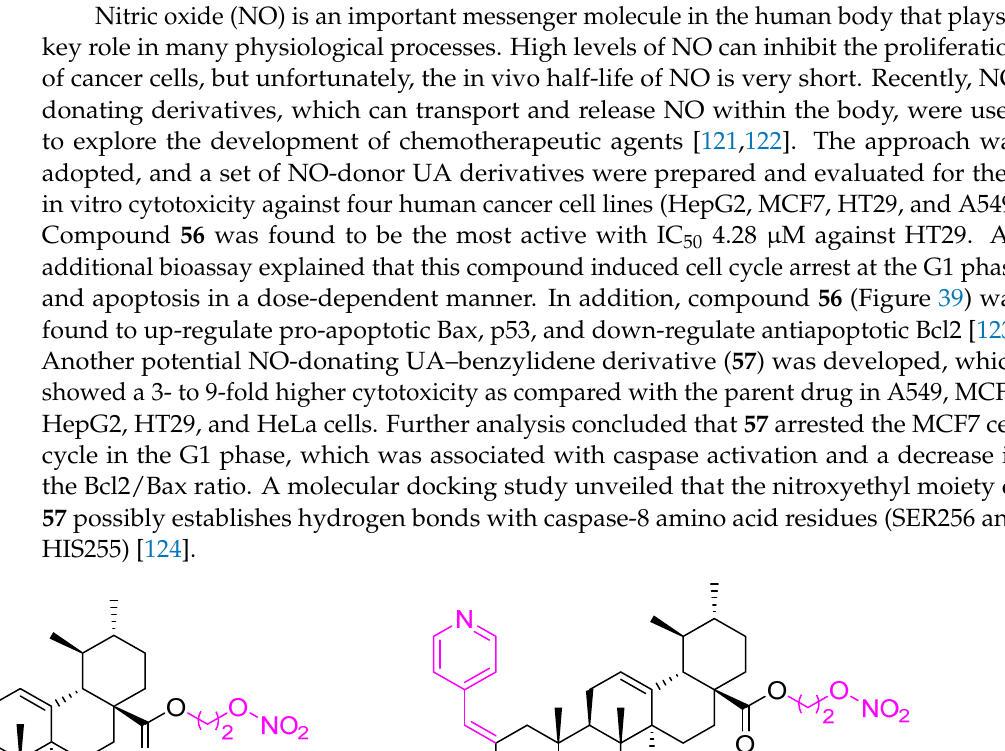
Figure 38. Structure of 55 .